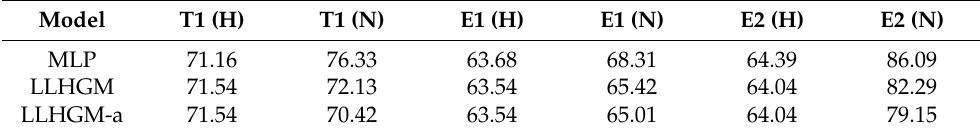
Table 5. Results obtained in the